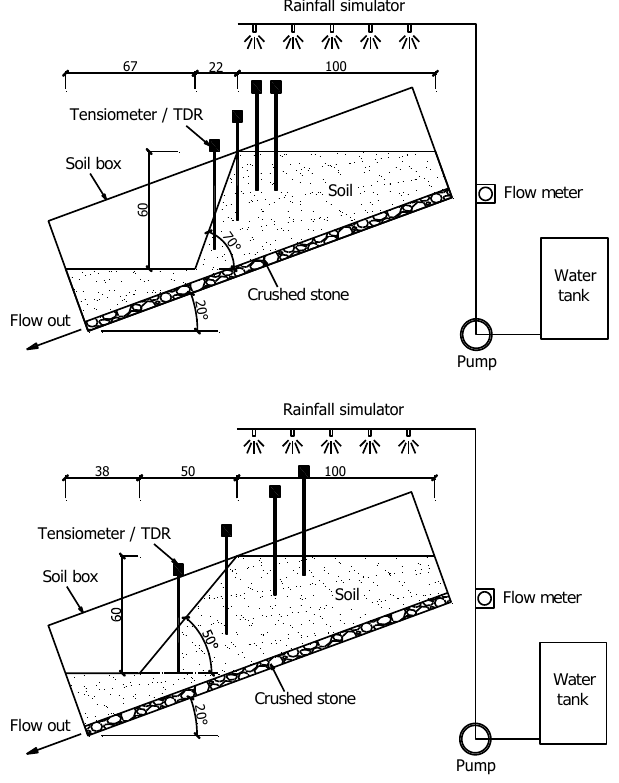
Figure 1. Experimental setup in Kumoh National Institute of Tech- nology, Korea: (a) model slope of 70 ◦ inclination, (b) model slope of 50 ◦